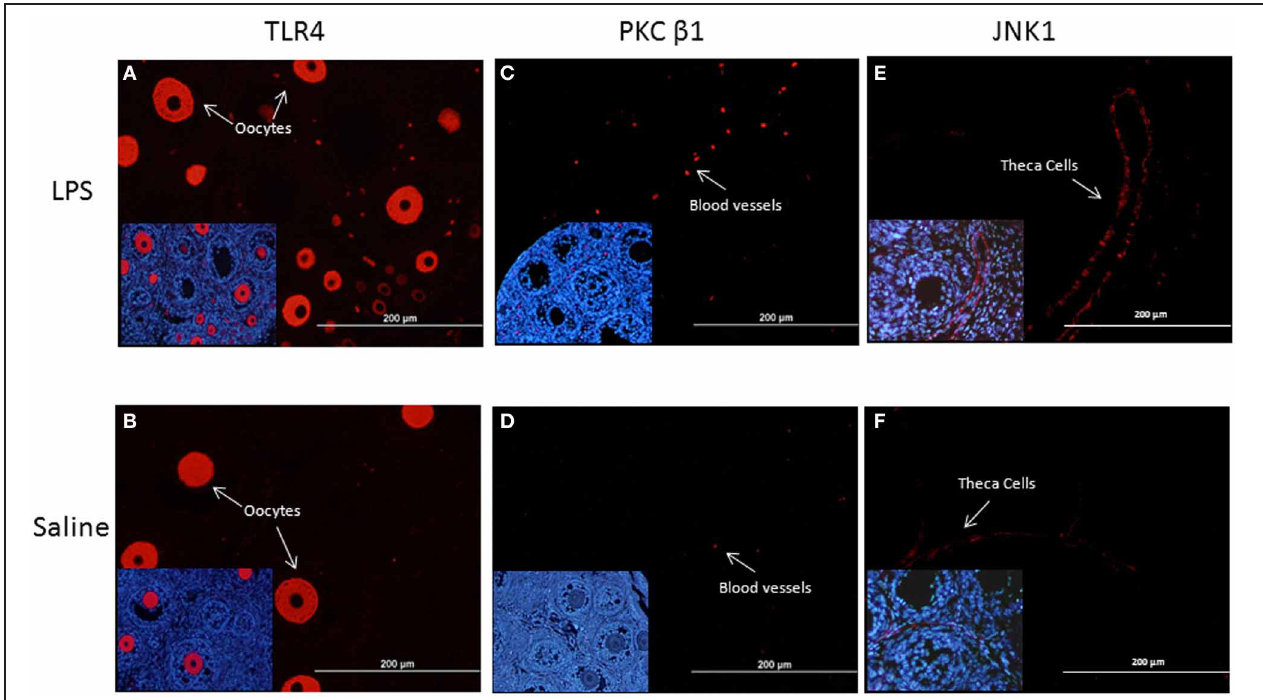
FIGURE 4 | Fluorescent immunolocalization of TLR4, PKC β , and JNK1 protein in the ovaries of LPS and saline-treated animals. (A–B) Represent TLR4 immunolabeling detected in the oocytes; (C–D) Represent PKC β 1 immunolabeling in ovarian blood vessels; (E–F) Represent JNK1